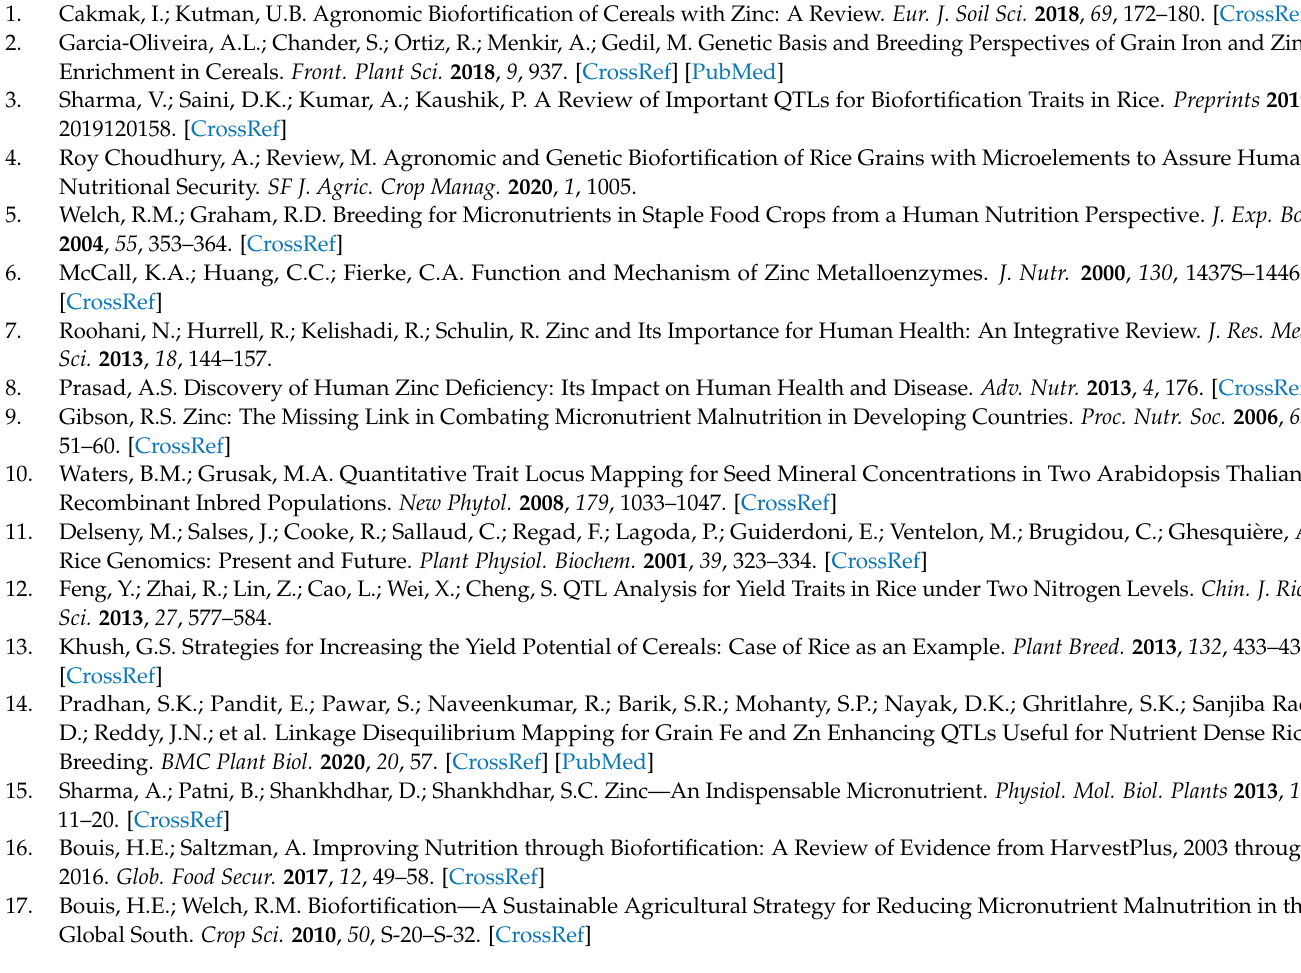
of genes in selected QTL regions. Table S3: List of candidate genes with transporter activity. Table S4: Fe and Zn data of 306 RILs. Table S5: Analysis of Variance. Figure S1: Frequency distribution of 92 RILs for mineral-related traits for all the four seasons. Figure S2: Frequency distribution of 92 RILs for agronomic and yield-related traits for all the four seasons. Figure S3: WEGO analysis with the identified candidate genes in the QTL regions. Figure S4: Relative expression of (a) Os06g0705700 and (b) Os06g0706100 in the flag leaf of rice